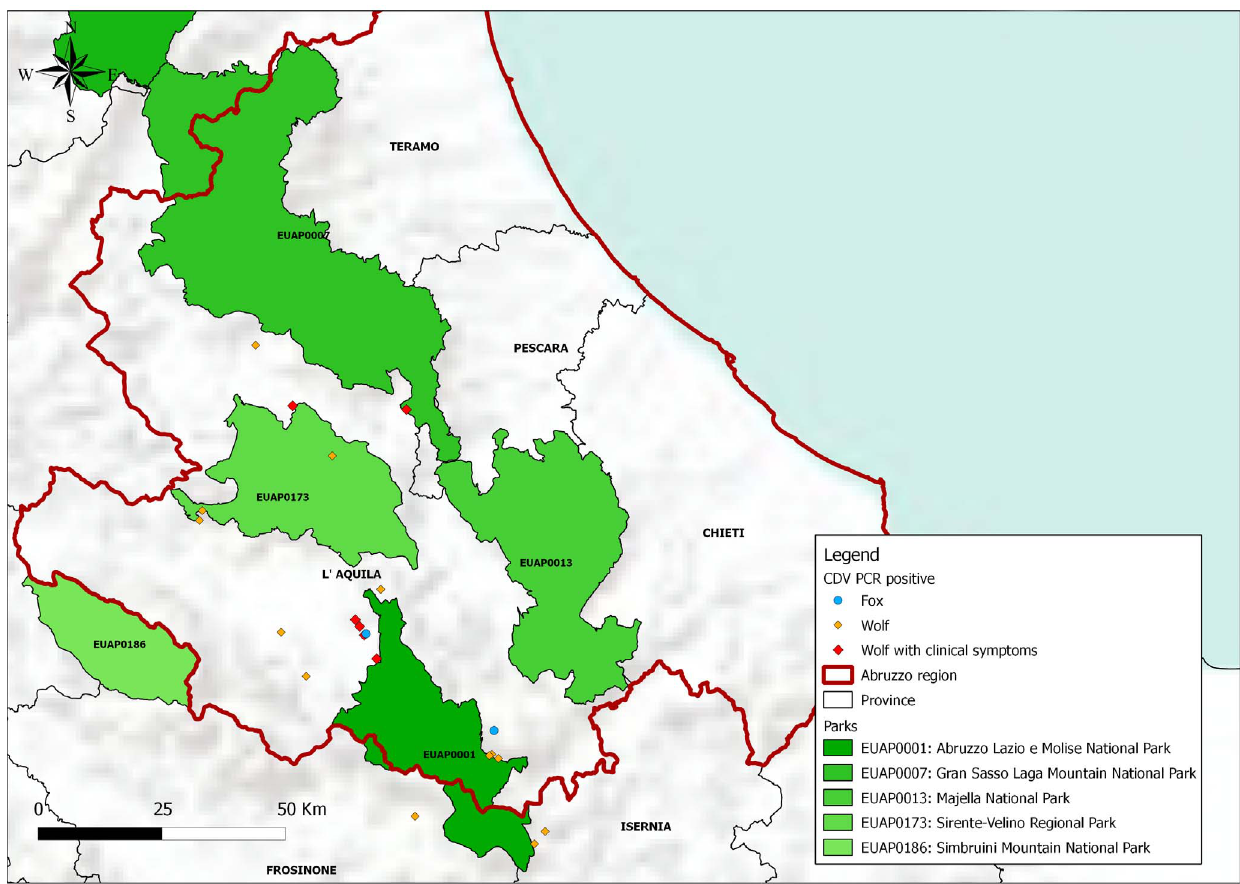
Figure 1. Map illustrating the distribution of CDV positive animals in Abruzzi region. Map was generated using Quantum GIS (QGIS) software, version 1.8.0.